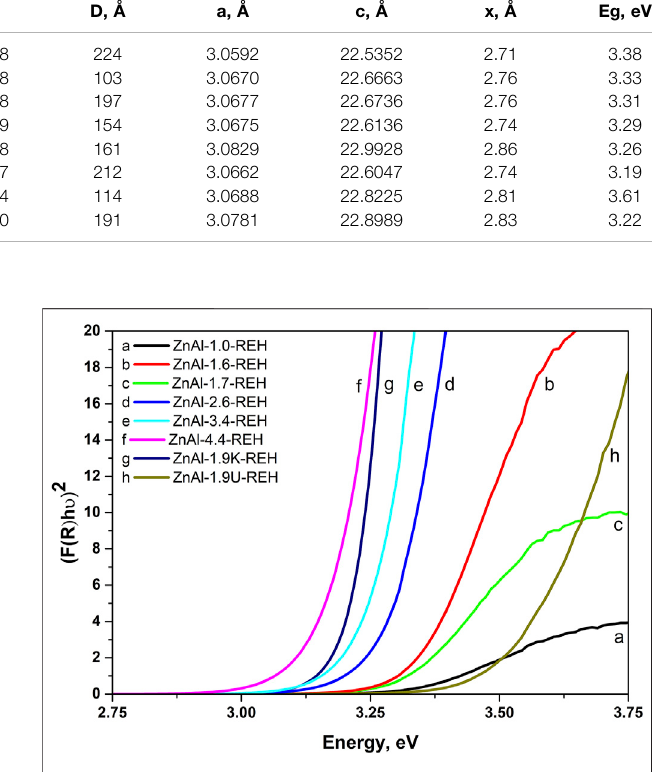
TABLE 1 | Crystallite size, lattice parameters, phase analysis and the shift of the edge of band from ex-situ DRS measurement of ZnAl-X-REH, ZnAl-1.9U-REH and ZnAl- 1.9K-REH RE-LDHs. Material